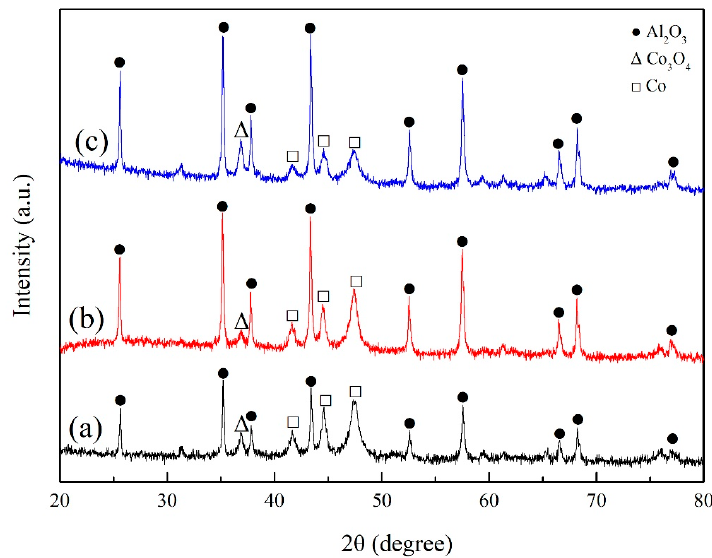
Figure 4 . XRD patterns of Co-coated Al 2 O 3 composite powders prepared by different Al 2 O 3 load: ( a ) 1 g/150 mL, ( b ) 1.5 g/150 mL and ( c ) 2 g/150 mL.